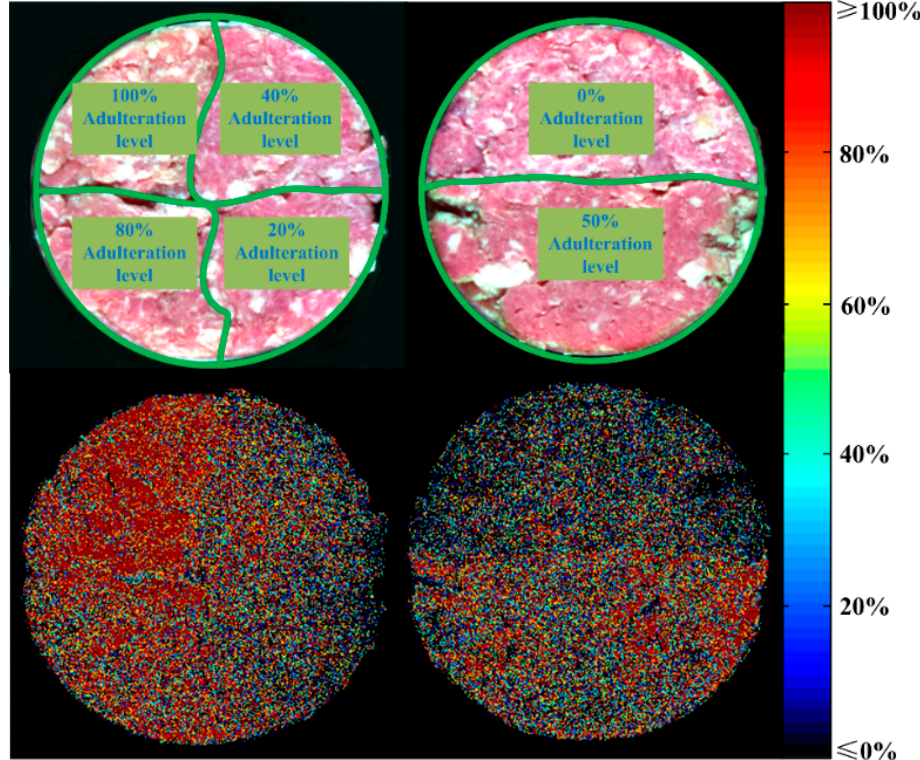
Figure 7. Visualization for control samples.